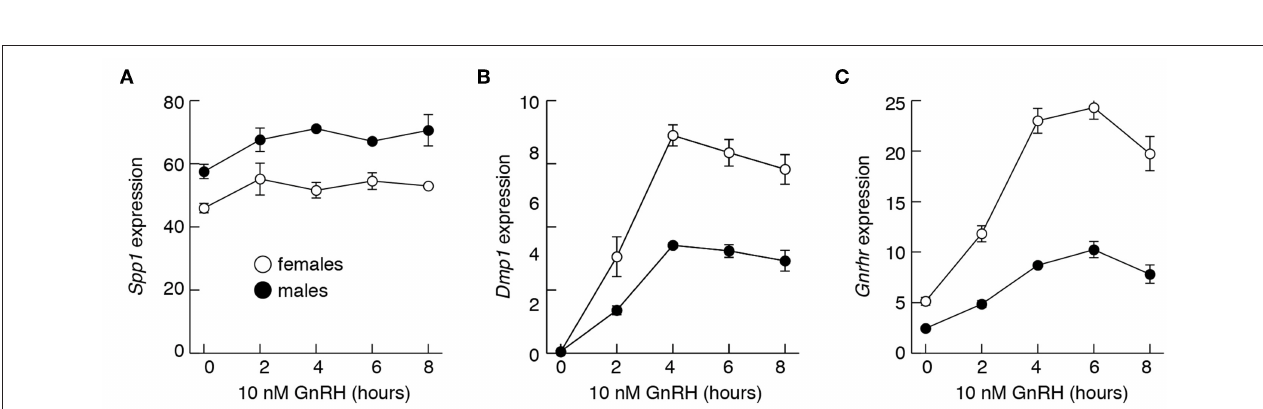
FIGURE 8 | The lack of an ability of GnRH to stimulate Spp1 expression in cultured anterior pituitary cells. Experiments were performed with cells from 4-week-old females and males. Cells were cultured overnight in medium 199 containing horse serum, which was replaced with BSA-containing medium 199 supplemented with 10nM GnRH in the morning, cultured for 0 to 8h, and mRNA was extracted for measurement of Spp1 (A) , Dmp1 (B) , and Gnrhr (C) expression.